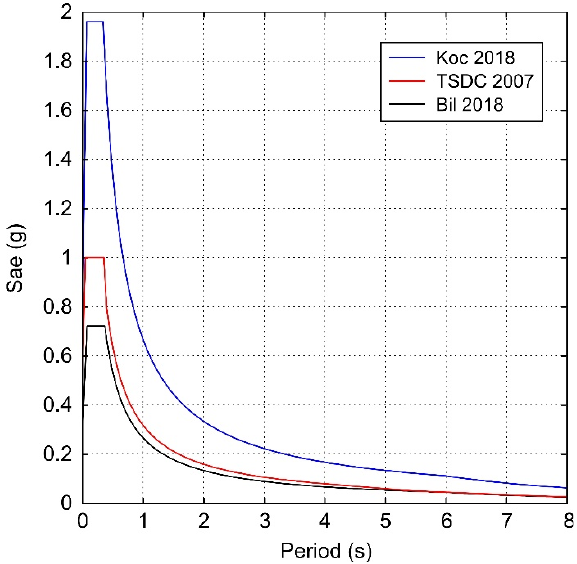
Figure 15. Comparison of the previous and updated horizontal design spectrum curves for the provinces with the highest and lowest PGA values.